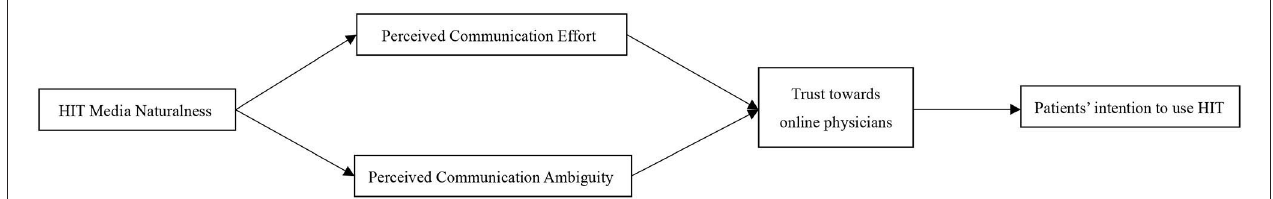
FIGURE 1 | Theoretical